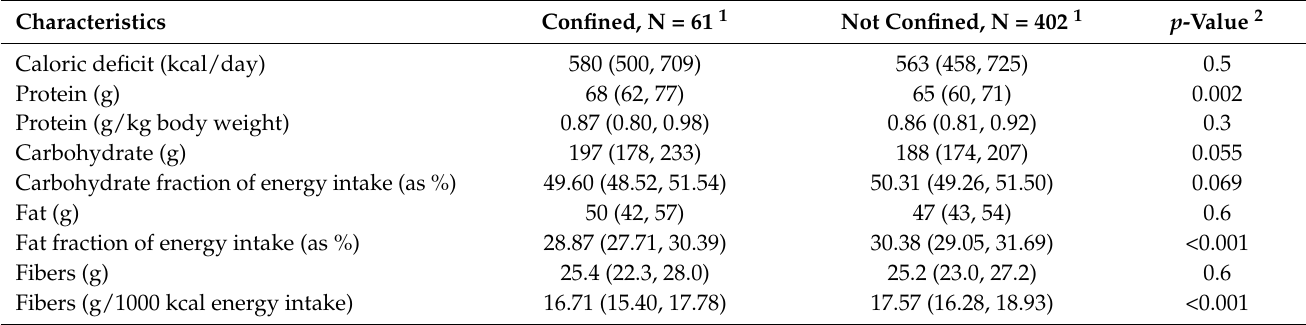
Table 2. Dietary composition of the prescribed diets in the confined and non-confined